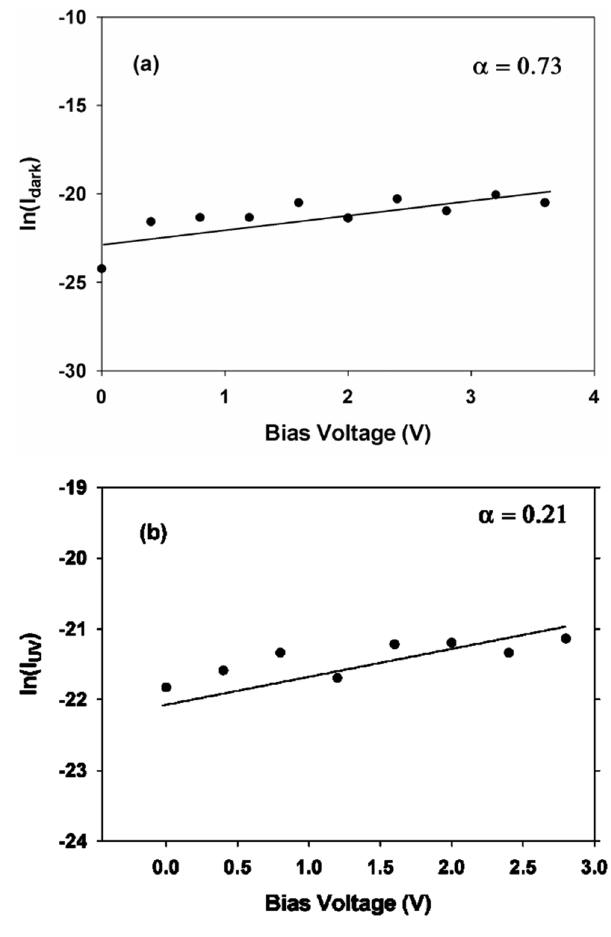
Figure 4. The determination of a for (a) dark condition and (b) UV condition.